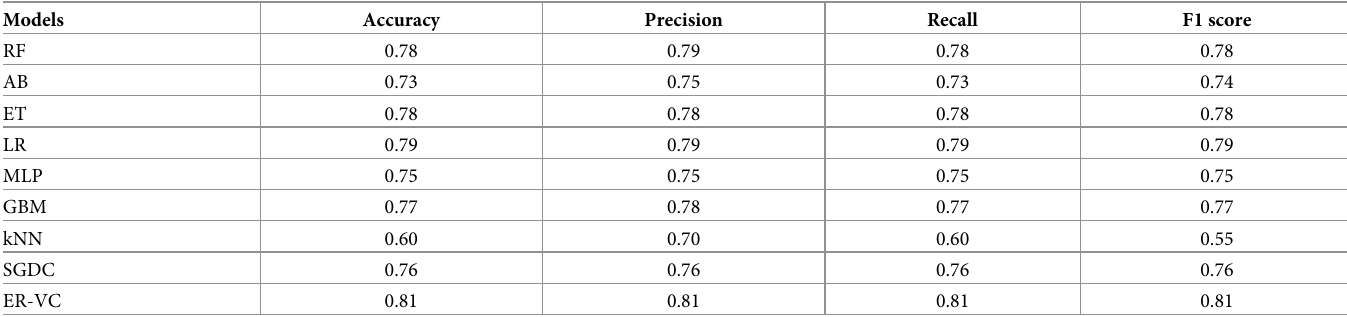
Table 7. Classification results of machine learning models using BoW with SMOTE.